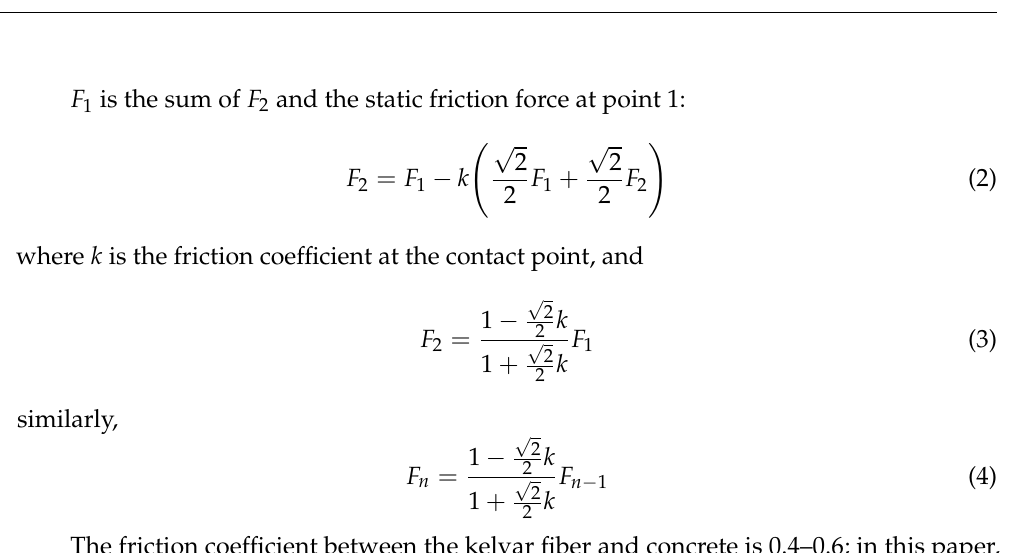
Figure 8. Way of CFR winding.